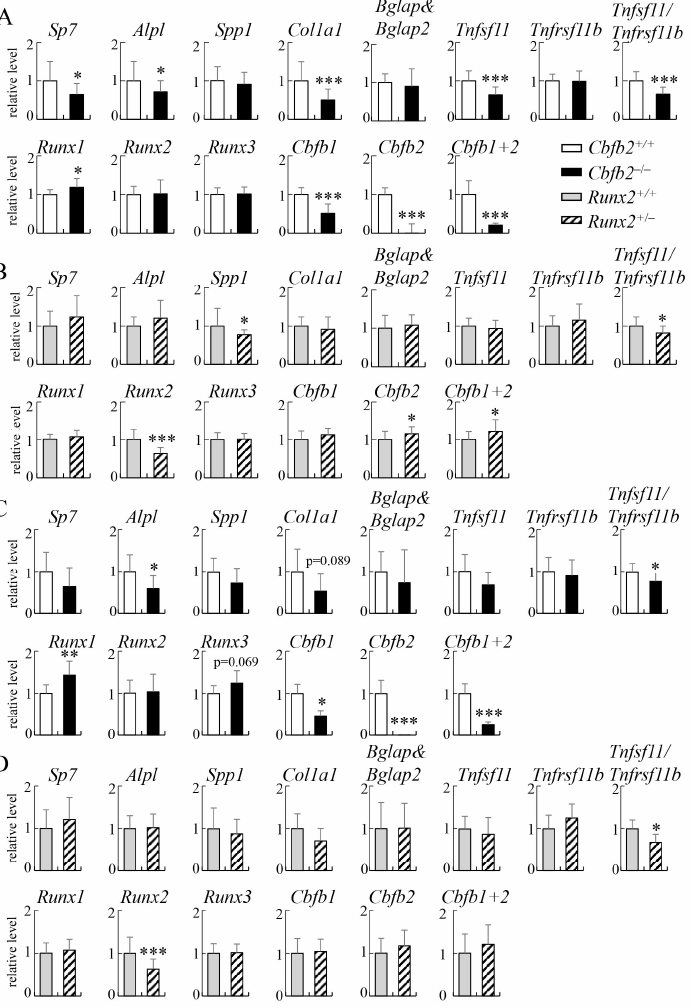
Figure 15. Real-time RT-PCR analyses of the expression of the genes related to osteoblast differ- entiation and osteoclastogenesis, RUNX family genes and Cbfb isoforms using RNA from tibiae and vertebrae at 4 weeks of age. Real-time RT-PCR analyses were performed using RNA from the tibiae ( A , B ) and vertebrae ( C , D ) in Cbfb2 +/+ and Cbfb2 − / − mice ( A , C ) and Runx2 +/+ and Runx2 +/ − mice ( B , D ). The primer pair for Bglap & Bglap2 amplifies both Bglap and Bglap2 , and that of Cbfb1+2 amplified both Cbfb1 and Cbfb2 . The ratios of Tnfsf11 and Tnfrsf11b are also shown. Data are shown as the mean ± SD. * p < 0.05, ** p < 0.01 and *** p < 0.001. The values of Cbfb2 +/+ or Runx2 +/+ mice were defined as 1 and relative levels are shown. The number of mice analyzed: Cbfb2 +/+ , n = 16; Cbfb2 − / − , n = 13; Runx2 +/+ , n = 19; Runx2 +/ − , n = 15 in the tibiae and Cbfb2 +/+ , n = 9; Cbfb2 − / − , n = 6; Runx2 +/+ , n = 7; Runx2 +/ − , n = 7 in the